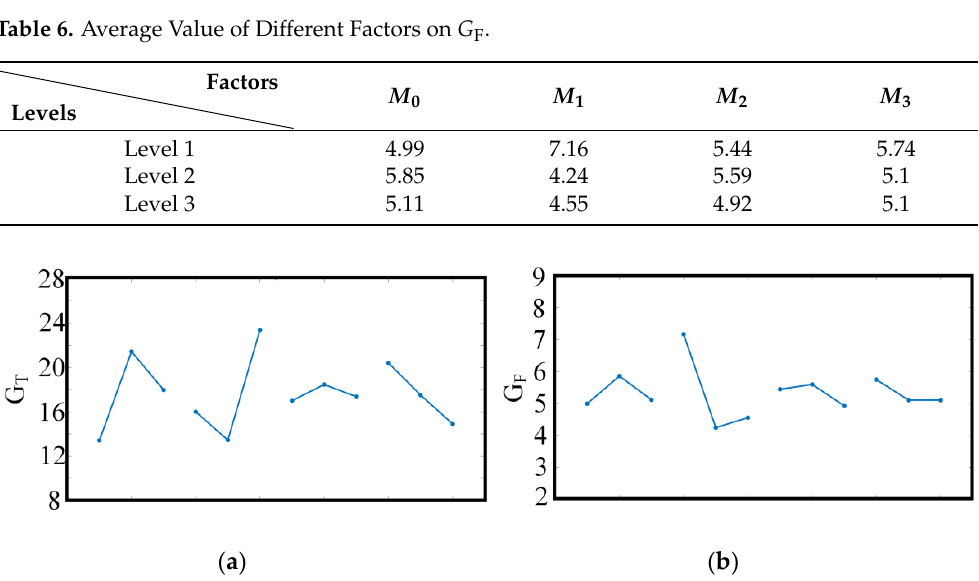
Figure 4. Influence of Each Variable Factor on the Objective Function. ( a ) the average values of target G T . ( b ) the average values of target G F